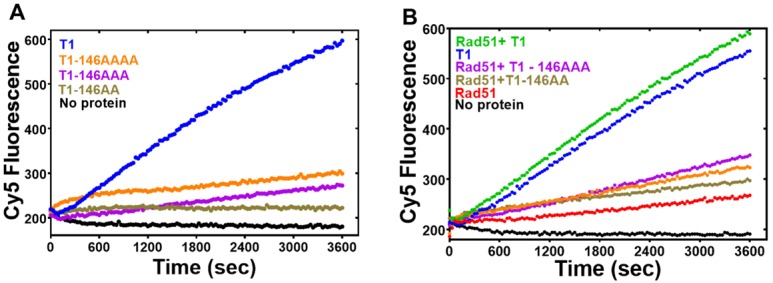
PALB2 DNA binding site mutants do not support strand exchange.(A) Forward strand exchange activity of PALB2 N-DBD DNA binding mutants. (B) The strand exchange activity of PALB2 N-DBD mutants in the presence of Rad51. Strand exchange reactions were performed with Cy5 and Iowa labelled 35 bp DNA at 2 μM protein concentration.